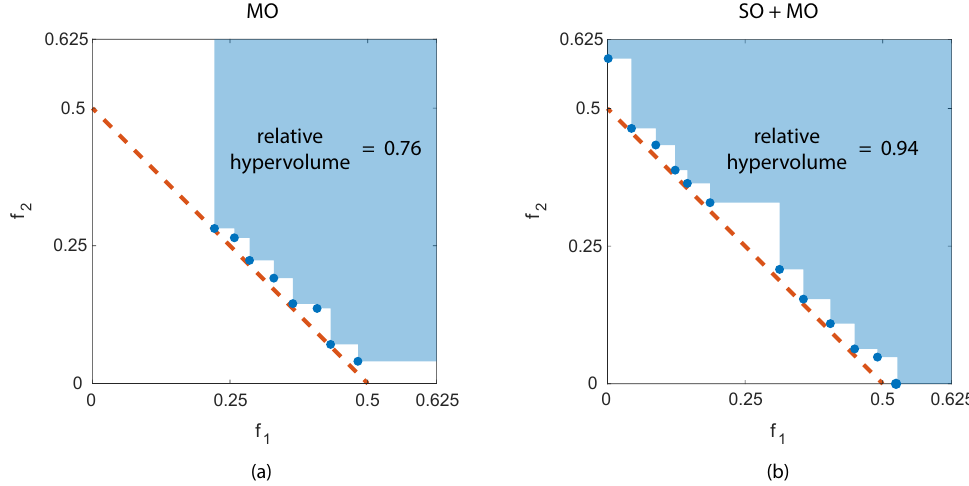
Figure 6. Analytical Pareto front (red dashed line) and solutions (blue dots) computed for DTLZ # 1. Panel ( a ) reports the performance of the MO algorithm, panel ( b ) of the SO+MO